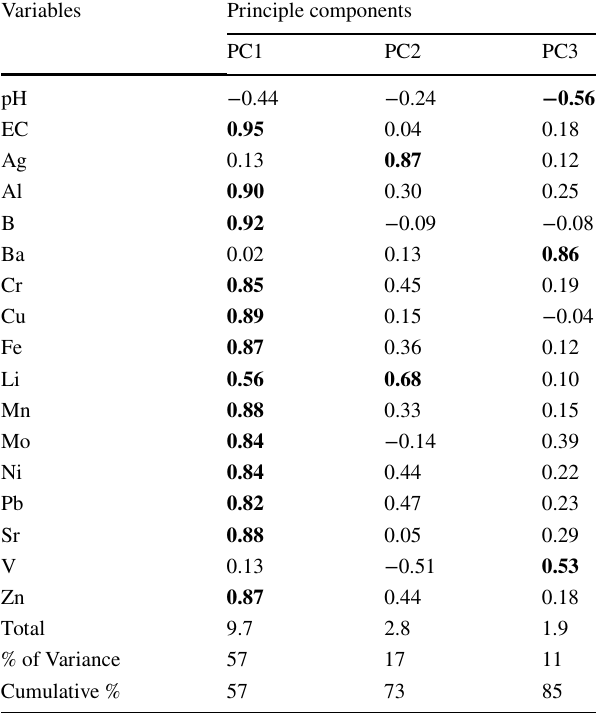
Table 6 Results of principal component